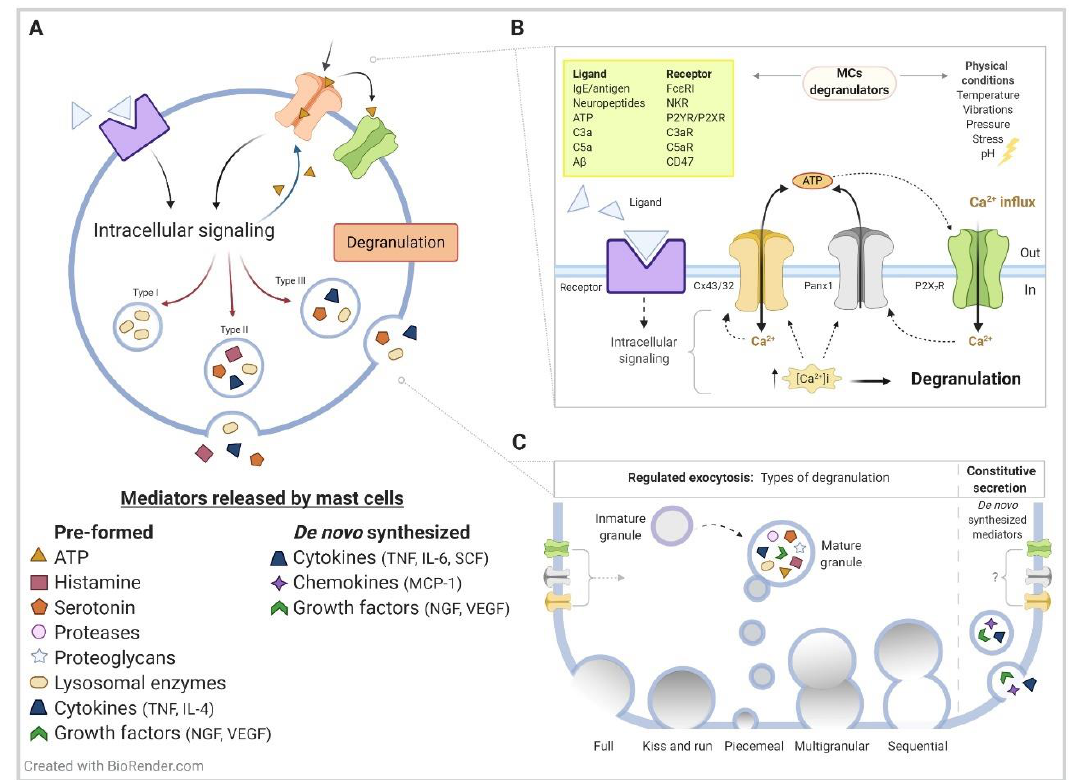
Figure 1. General mechanisms of degranulation from activated MCs . ( A ) Mast cells (MCs) are resident immune cell characterized by presenting numerous secretory granules in their cytoplasm in which they store pre-formed inflammatory mediators, such as biogenic amines (e.g., histamine, serotonin), growth factors (e.g., nerve growth factor (NGF), vascular endothelial growth factor (VEGF)), specific proteases (e.g., tryptase, chymase, carboxypeptidase A3), serglycin proteoglycan (such as heparin and chondroitin sulfate), cytokines (e.g., IL-4 and tumor necrosis factor (TNF α )), and adenosine triphosphate (ATP). These mediators are differentially packed in at least three different types (Types I, II, and III) of heterogenous secretory granules along the cell. Upon activation, these pre-formed mediators are rapidly released to the extracellular medium in a process called degranulation or regulated exocytosis, leading to immediate inflammatory reaction. Depending on the stimulus, MCs activation can also trigger the de novo synthesis of inflammatory mediators in a process called constitutive secretion, releasing molecules such as neuropeptides (e.g., substance P), growth factors (e.g., NGF, VEGF, platelet derived growth factor (PDGF)), cytokines (e.g., IL-6, IL-1 β , TNF α , SCF), and chemokines (e.g., Monocyte chemoattractant protein-1 (MCP-1)), modulating late phase inflammation responses. Both docking and fusion to the plasma membrane are dependent on increased levels of the Ca 2+ signal. The intracellular events triggered after MCs activation includes increasing membrane permeability to Ca 2+ , ATP release, and purinergic receptor recruitment, which are key components for MCs degranulation. ( B ) Different agents can induce MCs degranulation, including physical changes (e.g., temperature, vibrations, pressure, stress, pH) and ligand–receptor interaction (e.g., antigen–Immunoglobulin E (IgE)–Fc ε RI, ATP–P2Y/X receptors, and A β peptide–CD47). For the latter case, after intracellular signals are generated, connexins (Cxs) (potentially mediated by Cx43 and/or Cx32) and Panx1 HCs are eventually activated. HCs opening leads to massive ATP release, activating adjacent purinergic receptors in an autocrine way. Purinergic P2X receptor activation allows Ca 2+ influx and the direct recruitment of more Panx1 HCs opening, leading to a vicious loop resulting in degranulation. ( C ) Different types of degranulation have been reported for MCs, including full exocytosis, kiss-and-run exocytosis, piecemeal degranulation, multigranular, and sequential compound exocytosis. However, compound exocytosis and piecemeal degranulation are the prevailing forms of degranulation in human, mouse, and rat MCs. Although we have proposed HCs and purinergic receptors activation as key components for MCs degranulation, contribution on constitutive secretion have not been evaluated. For more information about inflammatory mediators, we recommend [10,20]; while for detailed reviews of regulated exocytosis mechanism, we recommend revising [13,14,21–23]. Finally, the evidence of hemichannels (HCs) contribution on MCs degranulation is indicated in